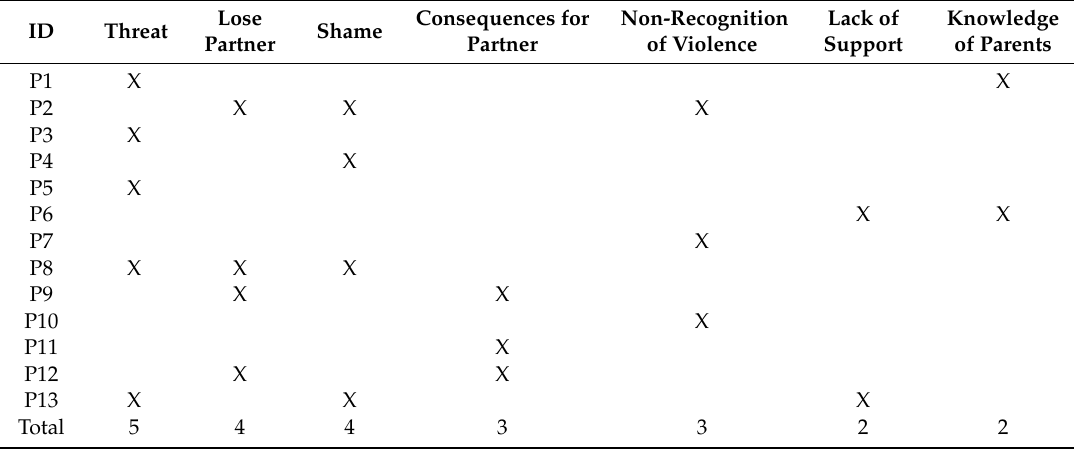
Table 4. Barriers to help-seeking or leave abusive dating